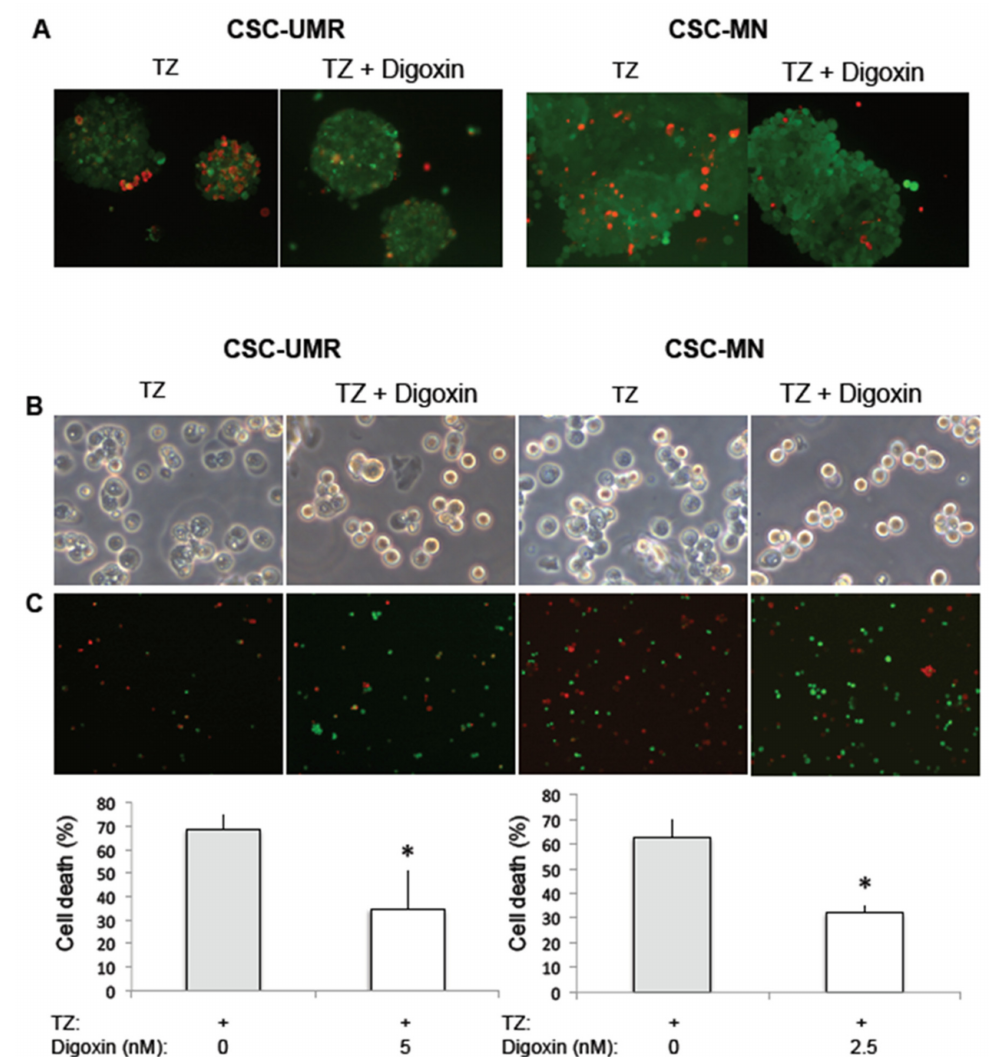
Figure 8. Digoxin rescues TZ-induced autosis in OS CSC-enriched populations. ( A ) The UMR or MN spheres were treated with TZ at 8 µ M for 48 h, in the absence or in the presence of Digoxin 5 nM. Representative pictures of spheres analyzed using the Live / Dead ® Viability / cytotoxicity Kit. Live cells are labeled in green, and dead cells display red nuclei ( × 10 magnification). ( B ) After sphere dissociation, the cells were treated by TZ at 30 µ M for 3 h, in the absence or in the presence of Digoxin. Phase contrast light microscopy pictures of the CSC-enriched populations in the di ff erent conditions. ( C ) Cell death analysis using the Live / Dead ® Viability / cytotoxicity Kit. Representative fields observed for each condition are presented ( × 10 magnification). Histograms represent mean cell death ± SEM obtained through the analysis of 500–600 cells per condition. *: p <